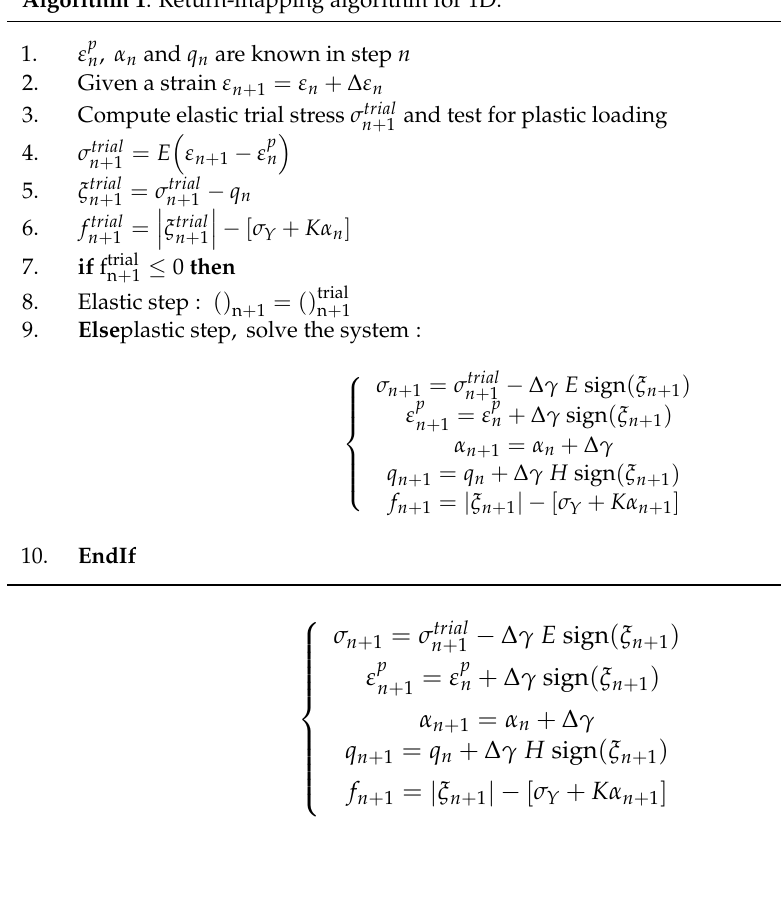
Algorithm 1 : Return-mapping algorithm for